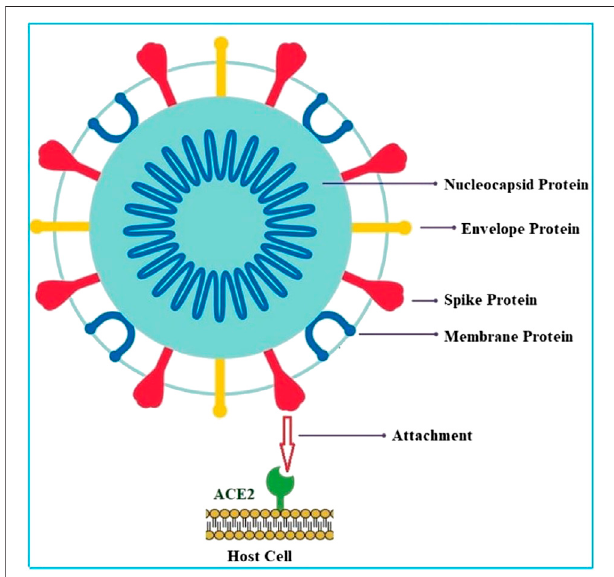
FIGURE 1 | Structure of SARS-CoV-2 and target binding